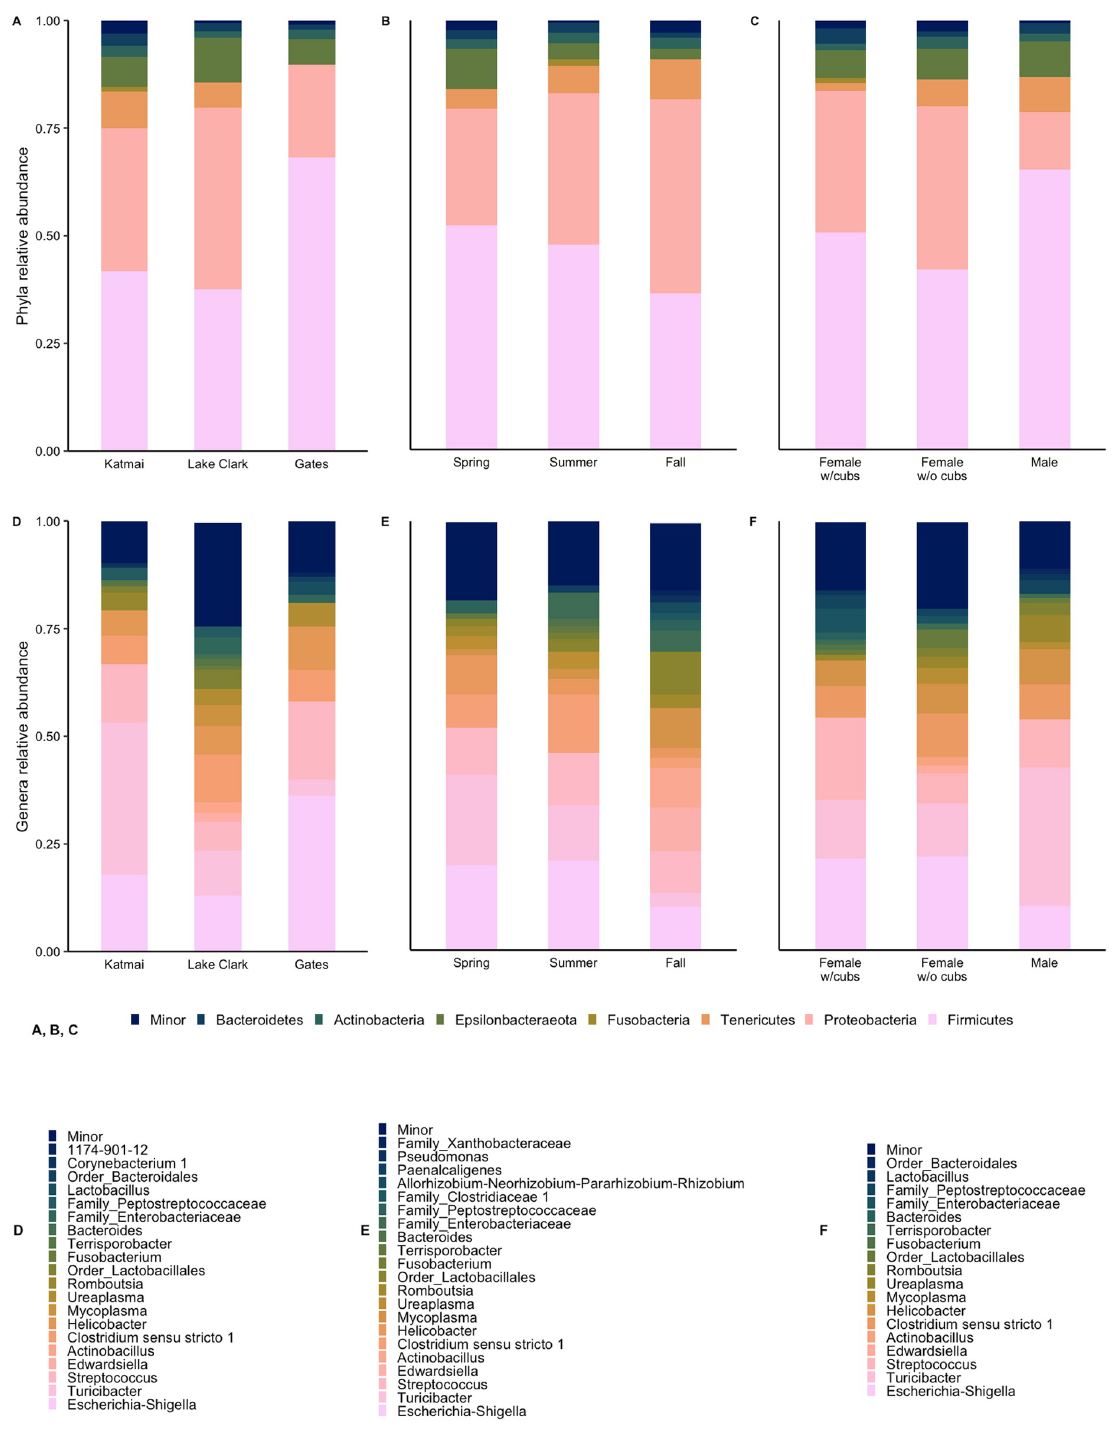
Fig 2. Gut microbial community composition in Alaskan brown bear. “Major” taxa include all taxa occurring at � 1% relative abundance; “minor” taxa are those occurring at < 1% relative abundance. A) Relative abundance of the seven major phyla identified at each study area; B) relative abundance of the major phyla detected in spring, summer, and fall; C) relative abundance of the major phyla detected in females with cubs, females without cubs, and males; D) relative abundance of the major genera found in each park; E) relative abundance of the major genera found in spring, summer, and fall; and F) relative abundance of the major genera found in females with cubs, females without cubs, and males.